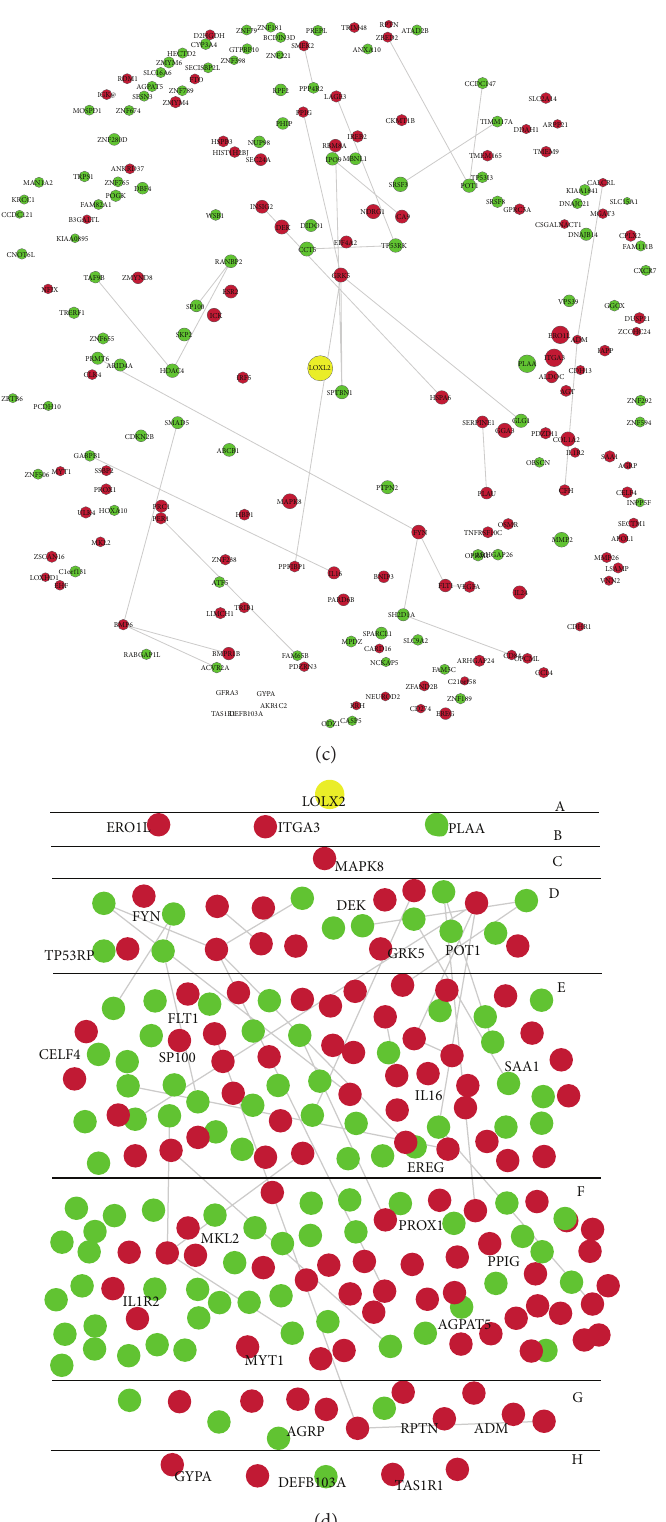
Figure 4: Prioritization analyses of e13-WT-DEGs based on the PPI subnetwork. (a) PPI subnetwork of e13-WT-DEGs. (b) Random Walk with Restart algorithm was used to score all proteins in the PPI network with LOXL2 set as the seed node. The size of each node in the PPI subnetwork was designed as a gradient based on the scores. (c) The e13-WT-DEGs were extracted from (b) to illustrate their sizes. (d) The DEGs were rearranged according to their closeness to LOXL2-e13